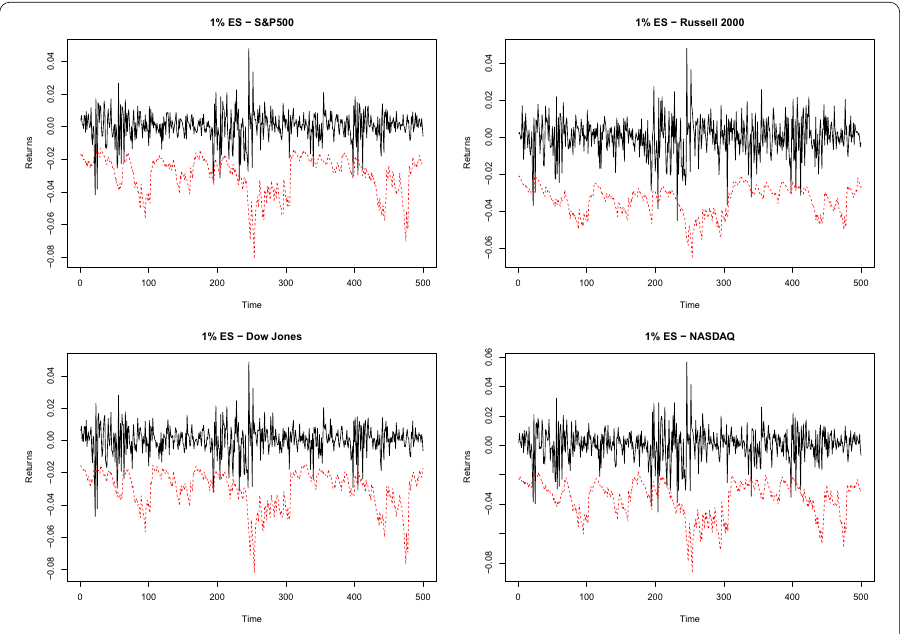
Fig. 3 Results for Model 1. The time series of returns is in solid (black) line and the one-step ahead forecasts ES are in dashed (red) of −